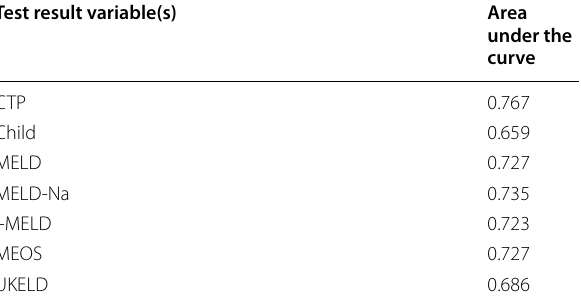
Table 5 AUROC of various predictor model in